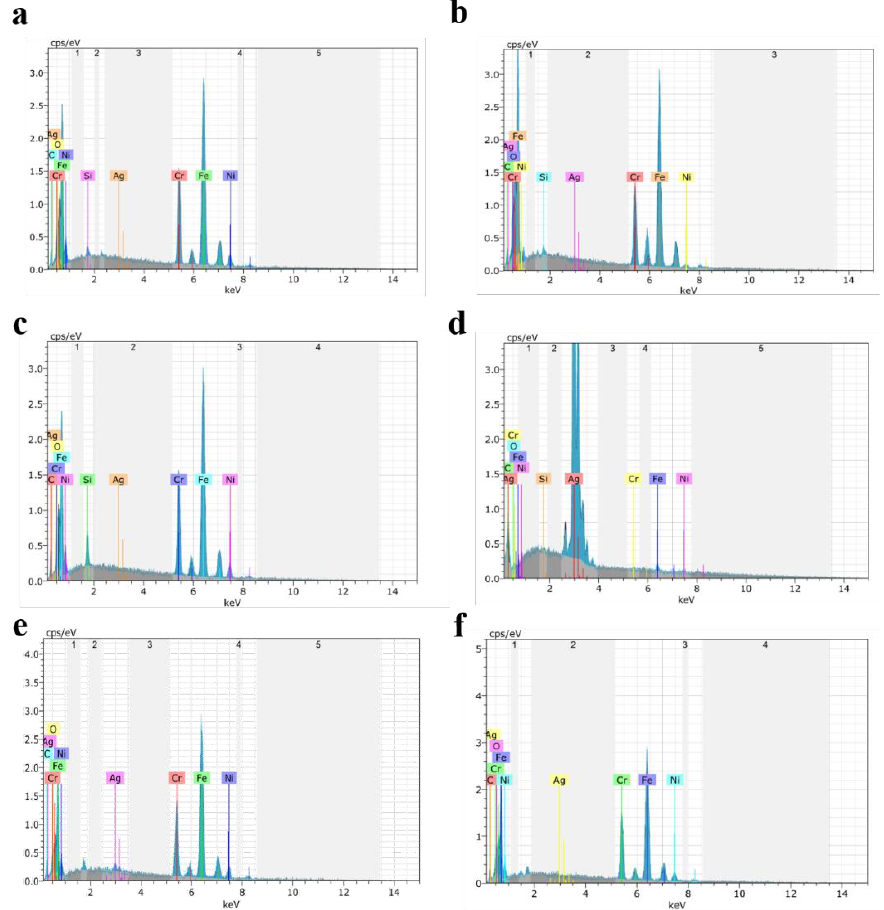
Figure 2. EDS spectra of ( a ) CE body; ( b ) CE handle; ( c ) Inano-Ag-IE body; ( d ) Inano-Ag-IE handle; ( e ) Ag-CE body, and ( f ) Ag-CE handle.